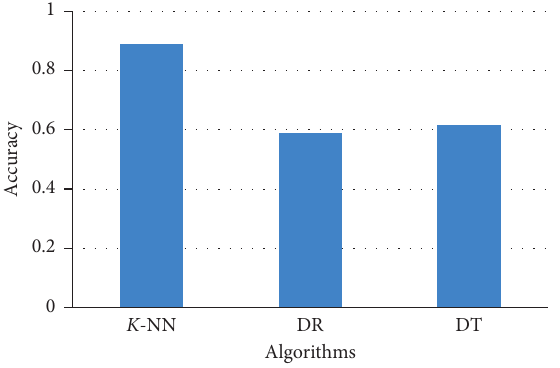
Figure 16: Overall comparison of algorithms for the proposed study.